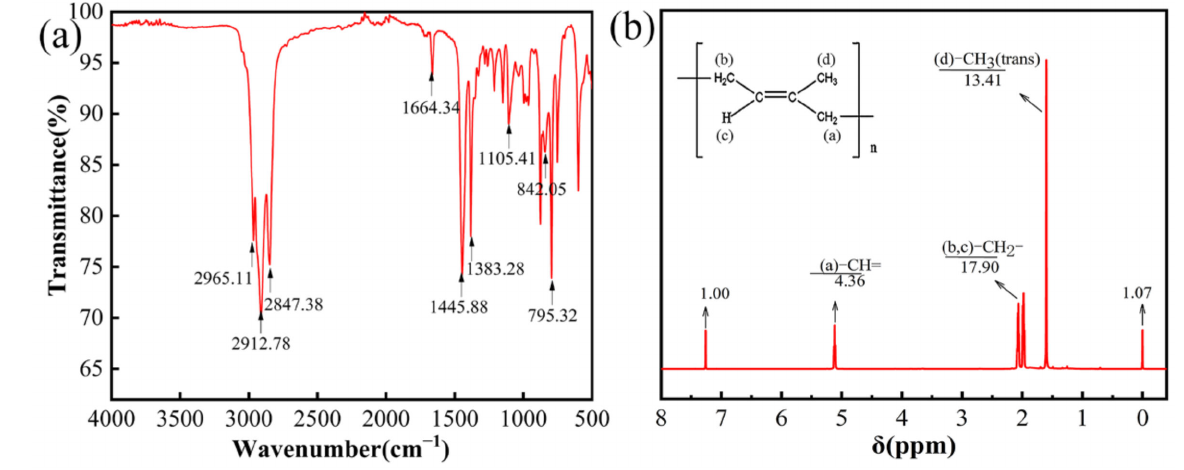
Figure 9. ( a ) FT-IR spectroscopy and ( b ) 1 H-NMR spectrum of the extracted gutta-percha.